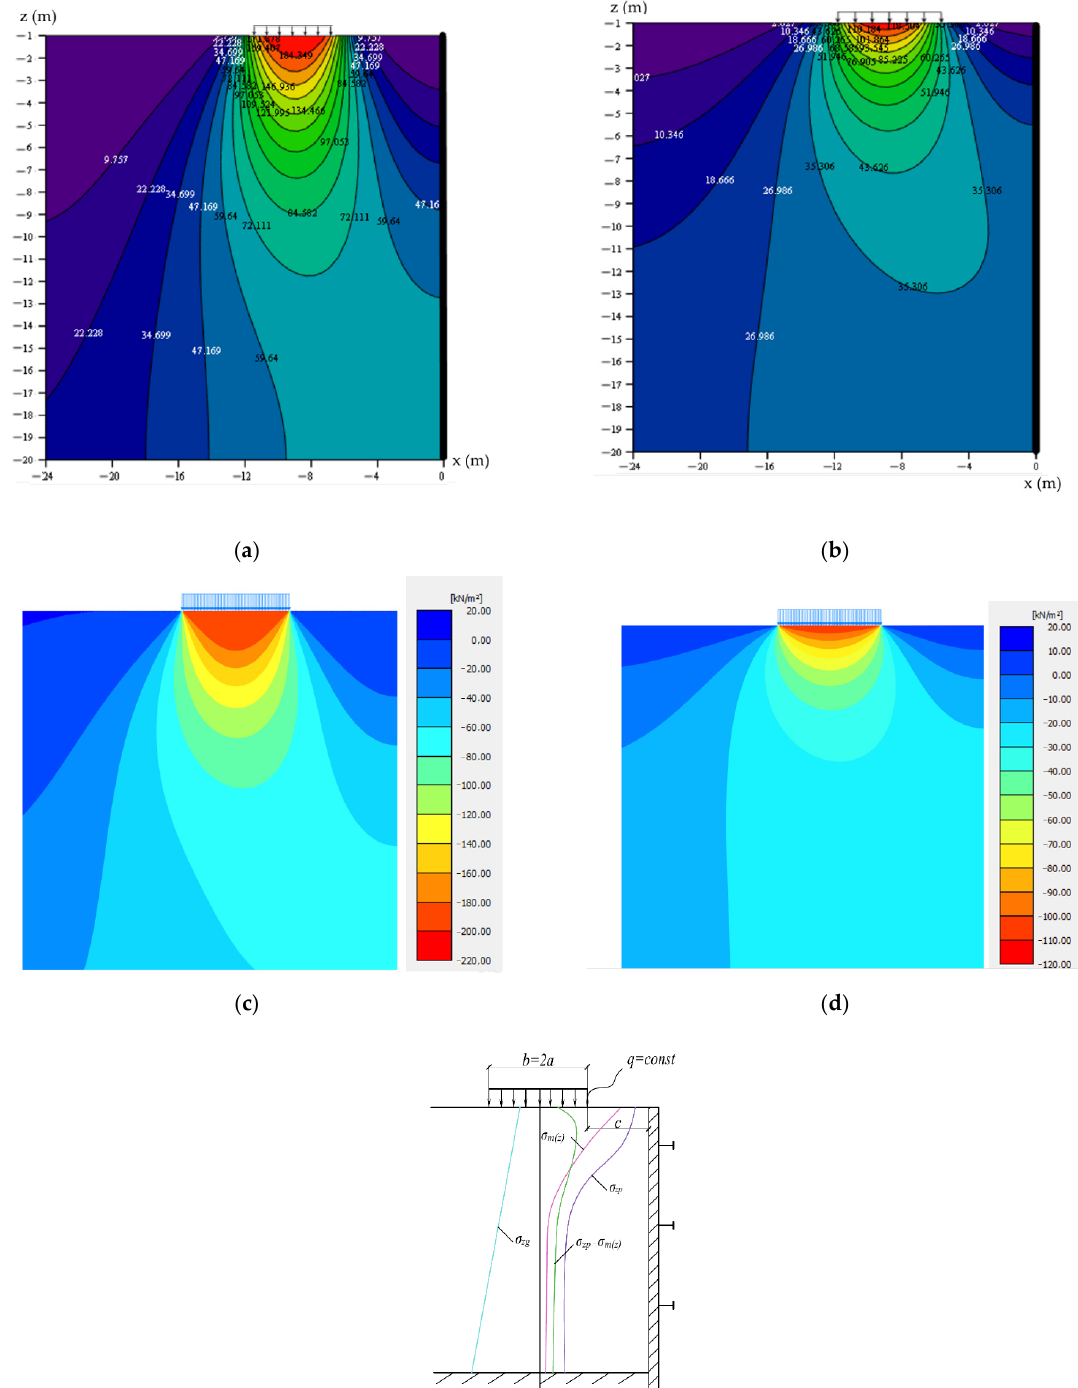
Figure 6. Results of analytical and numerical calculations of stress components at q = 200 kPa, c = 6 m, b = 2 a = 6 m. Isolines of vertical stresses σ z obtained using MathCAD software package ( a ); isolines of mean stresses σ m obtained using MathCAD software package ( b ); isolines of vertical stresses σ z obtained using PLAXIS 2D software package ( c ); isolines of mean stresses σ m obtained using PLAXIS 2D software package ( d ); the calculation pattern applied to determine shear and volumetric deformations of the soil basis based on the physical equations derived by H. Hencky, including σ zp , σ zg , σ zm epures ( e